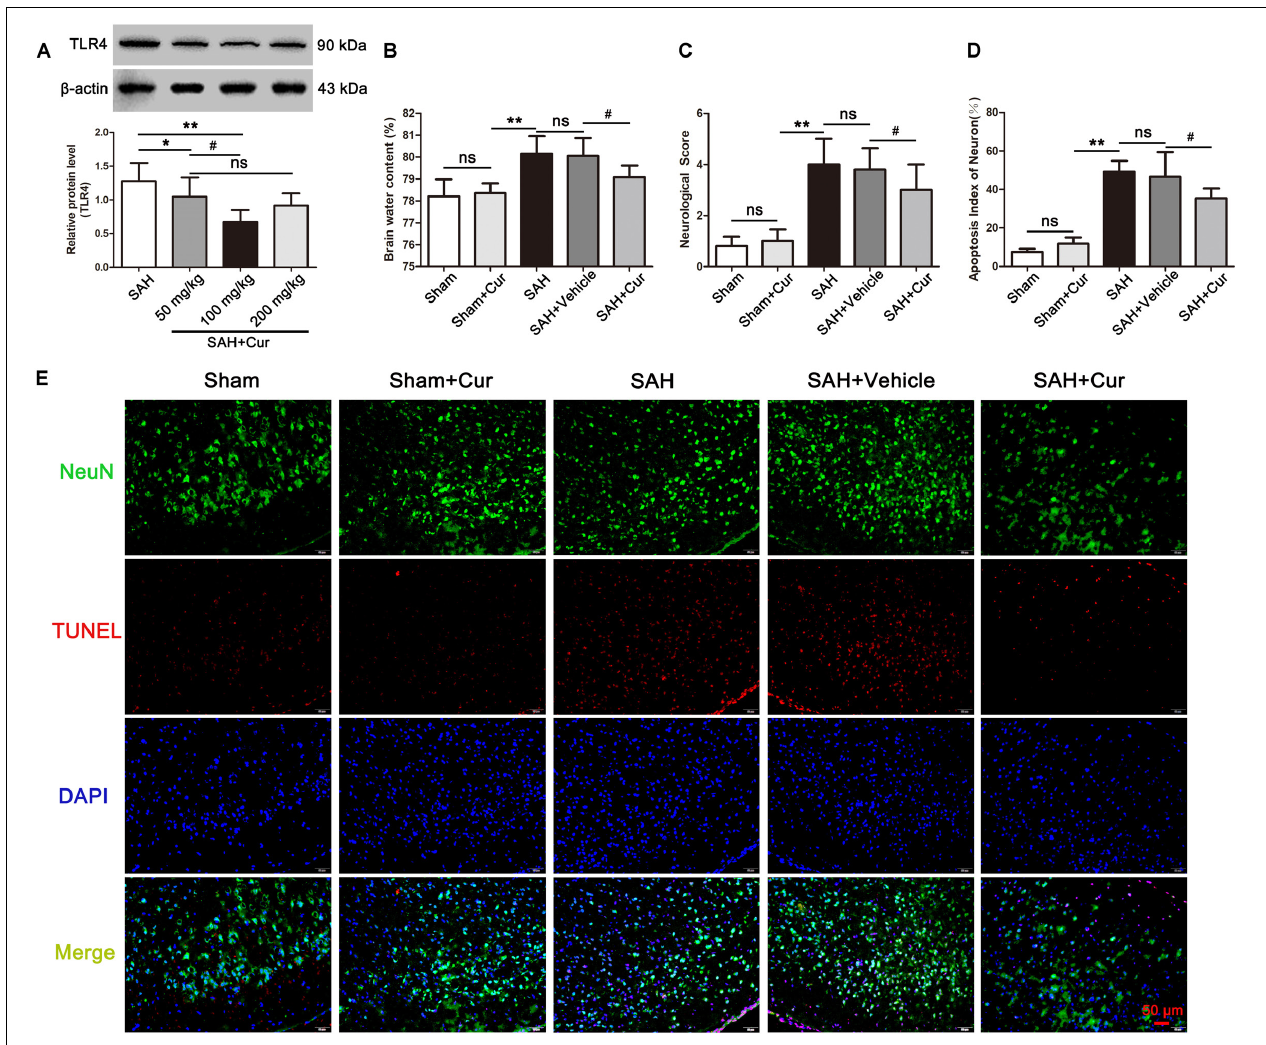
FIGURE 4 | Effects of curcumin (cur) on expression of toll-like receptor 4 (TLR4) and neuroprotection, evaluated by brain water content, neurological score, and TUNEL staining at 24 h after SAH. (A) Curcumin with 100 mg/kg significantly reduced the protein level of TLR4 at 24 h post SAH. (B,C) Curcumin treatment ameliorated the brain water content and neurological function at 24 h after SAH as compared with the SAH + vehicle group. (D) Representative immunofluorescence staining images of TUNEL (NeuN = green, TUNEL = red, DAPI = blue) (E) Administration of curcumin remarkably decreased the amount of TUNEL-positive neurons at 24 h after SAH compared with the SAH + vehicle group. The quantitative data are the mean ± SD [ n = 5, each; ∗ p < 0.05, ∗∗ p < 0.01 vs. SAH group, Sham + Cur group; # p < 0.05 vs. SAH + Cur (50 mg/kg) group, SAH + Vehicle group; ns p > 0.05]. Scale bars = 50 µ